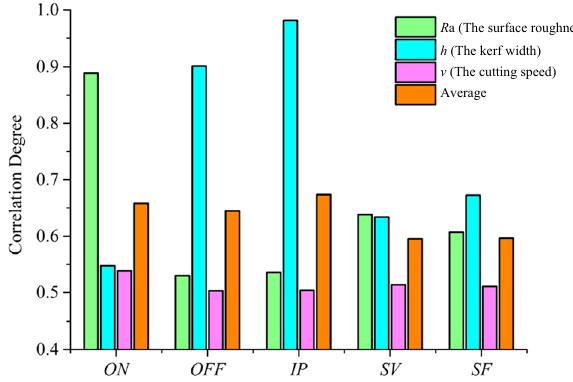
Figure 6: Relative correlation between electrical parameters and